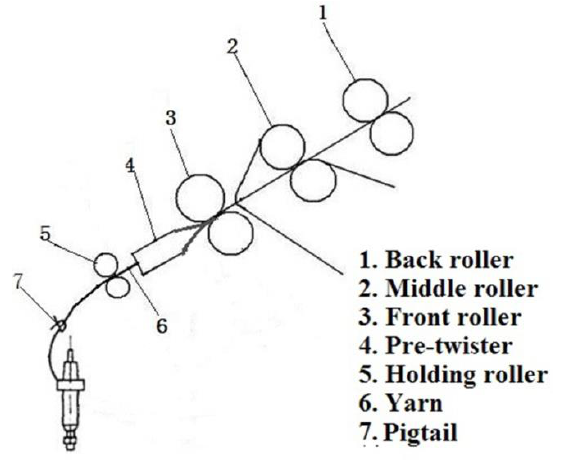
Figure 1. Schematic diagram of the spinning system.